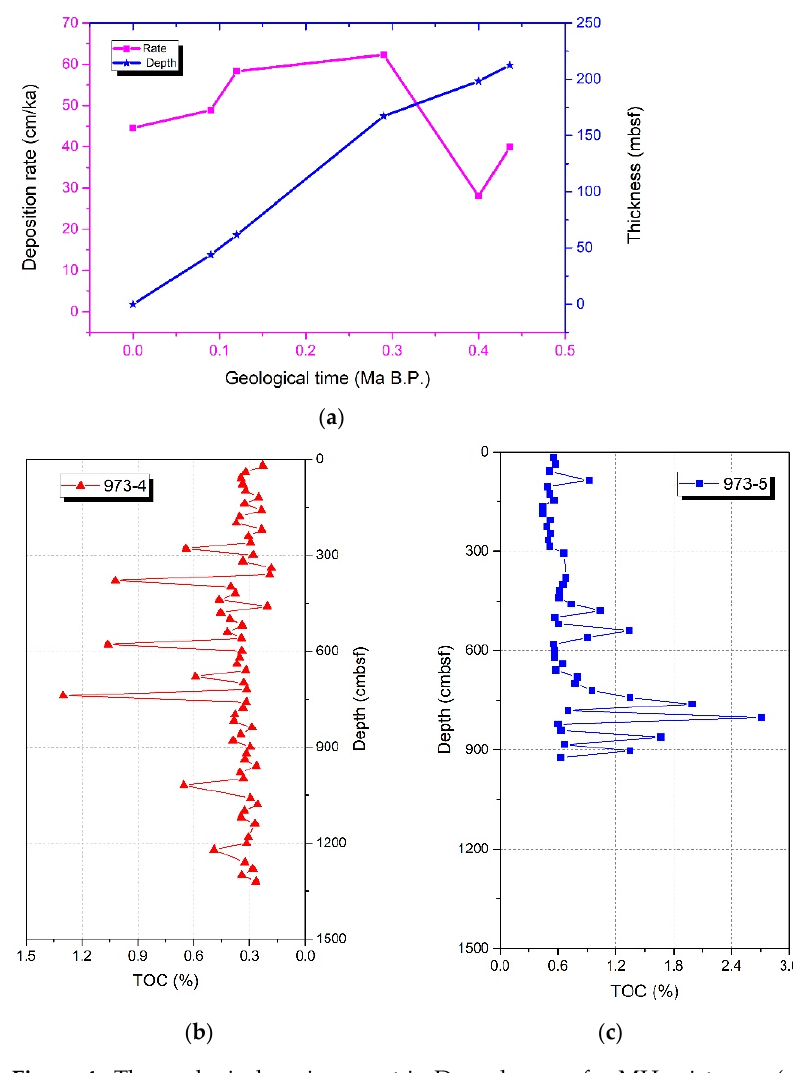
Figure 4. The geological environment in Dongsha area for MH existence. ( a ) Deposition rate in corresponding geological time, and ( b , c ) tested TOC concentrations in this area.